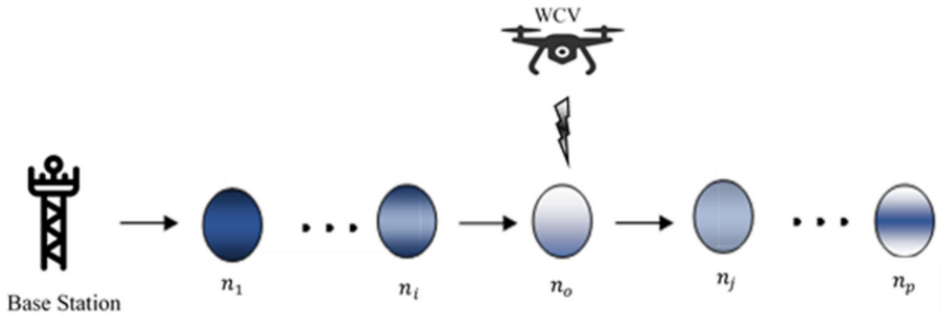
Figure 1. A typical WRSN with a WCV charging a low-energy sensor